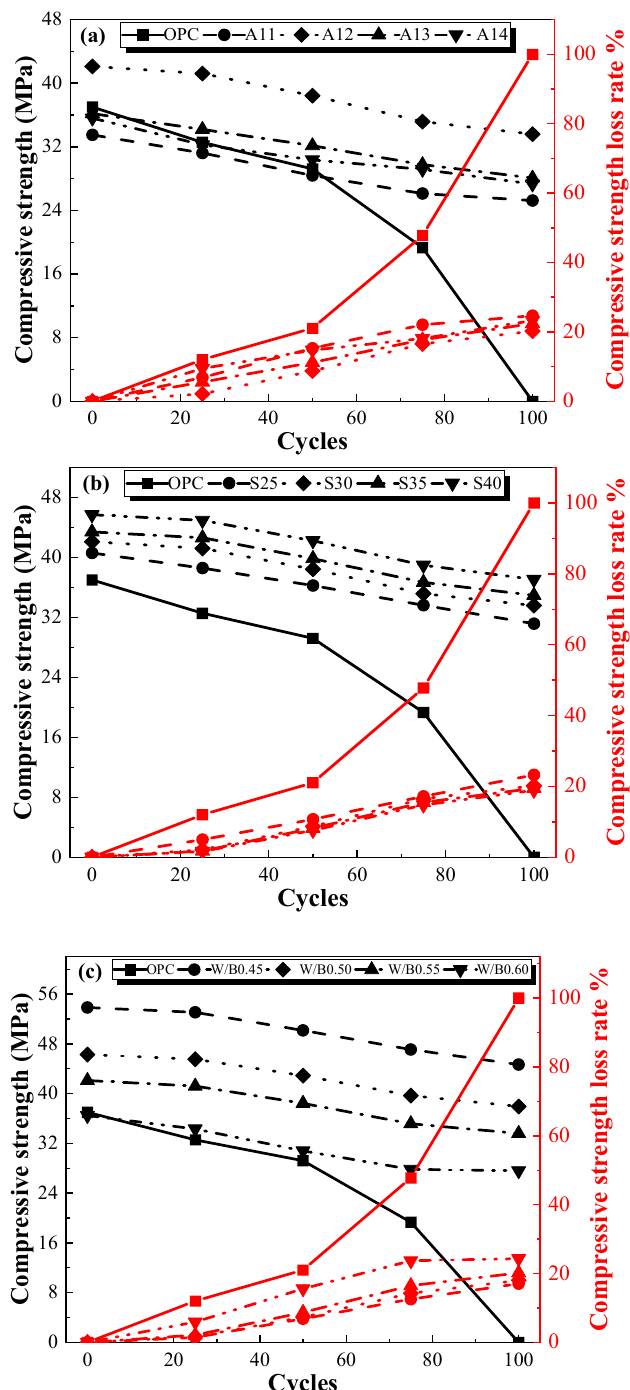
Figure 7. Effects of ( a )alkali content, ( b )slag content, and ( c ) water-to-binder ratio on the compressive strength of specimens.